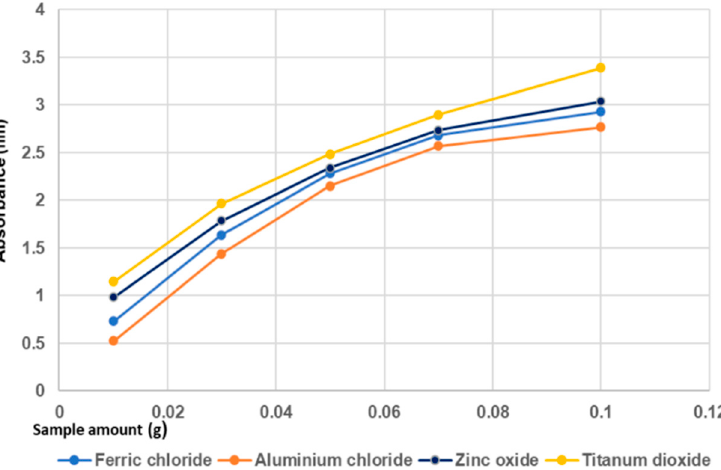
Figure 7. Comparison of different method (coagulation agents vs. adsorption on semiconductors materials) on phosphorus removal performance from wastewater. materials) on phosphorus removal performance from